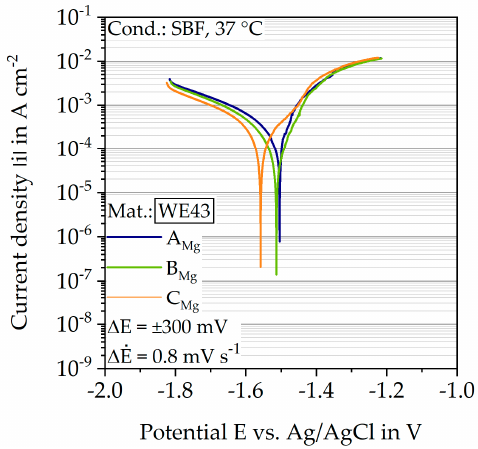
Figure 16. Results of the potentiodynamic polarizations measurements of the three batches in SBF, shown as Tafel plot.